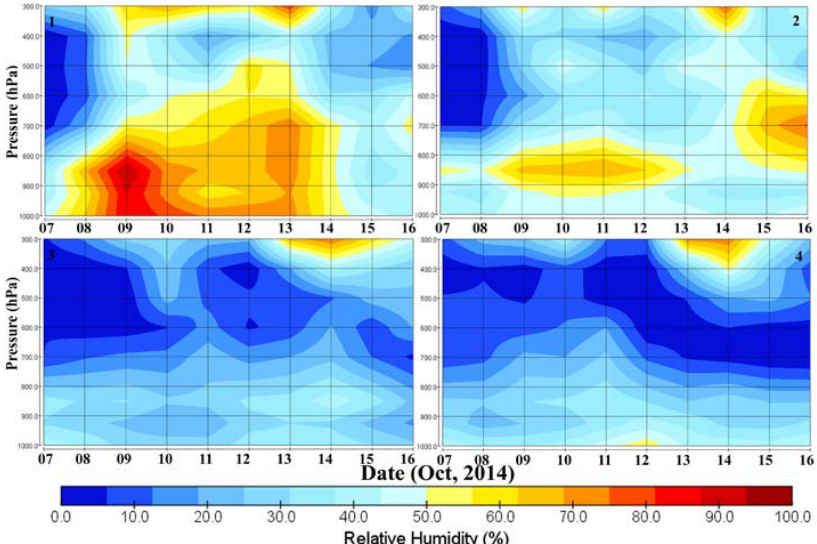
Figure 5. Vertical profile of relative humidity (RH) at four locations (1, 2, 3, and 4) along the track of the cyclone and at the location in the Indo-Gangetic Plain.